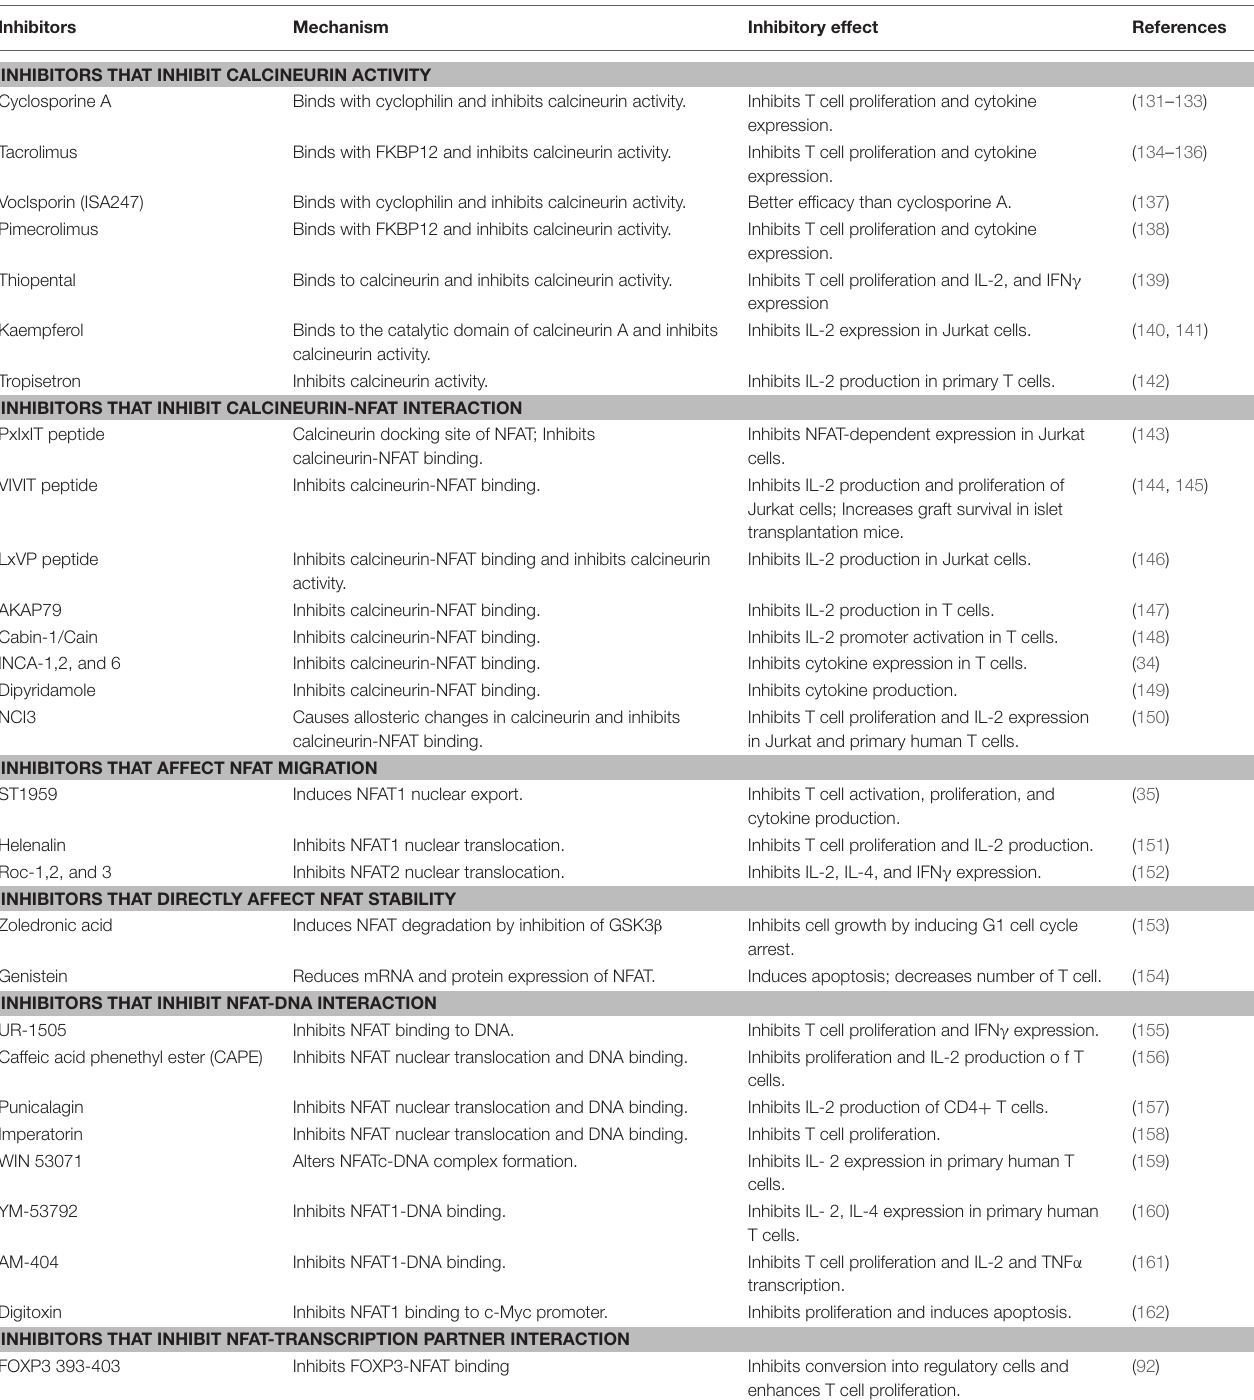
TABLE 2 | Calcineurin-NFAT inhibitors and their